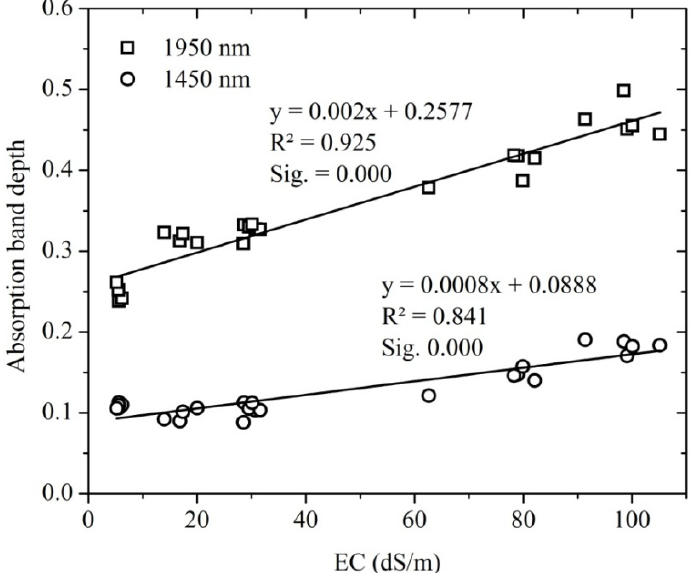
Figure 12. The relationship between the depths of the absorption bands centered at 1450 nm and 1950 nm and the values of electrical conductivity (EC) for MgCl salinization. Results refer to samples non-treated chemically with gypsum (NTG).